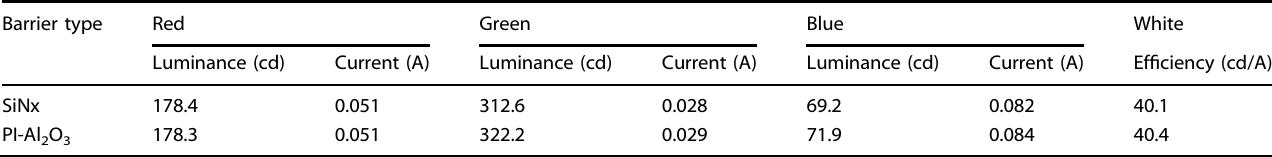
Table 1. Driving characteristics of fl exible OLED display with SiNx barrier layer and the PI-Al 2 O 3 hybrid barrier nanolayer. Barrier